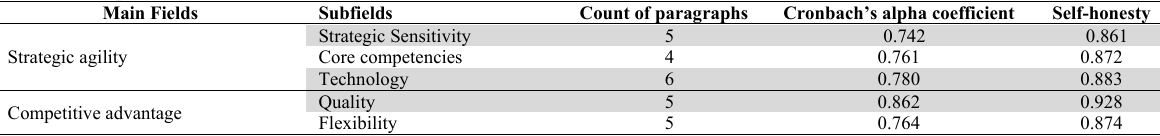
Cronbach Alpha coefficient for all fields Main Fields